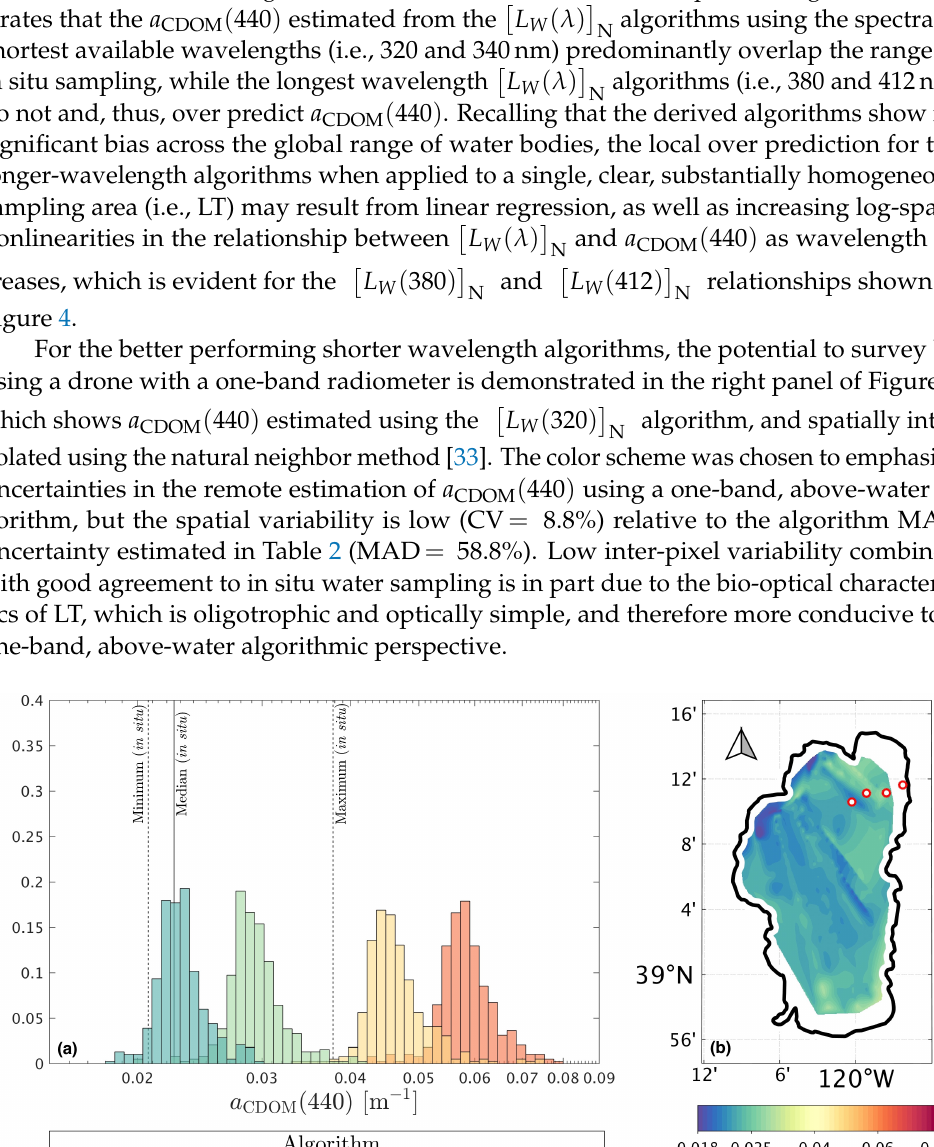
L W ( 320 ) algorithm N (cid:2)